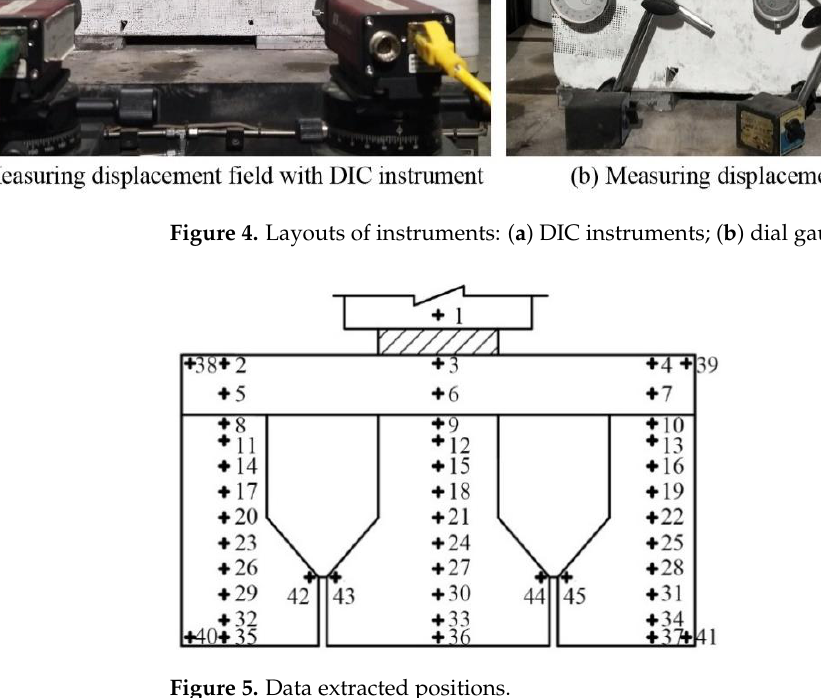
Figure 5. Data extracted positions.